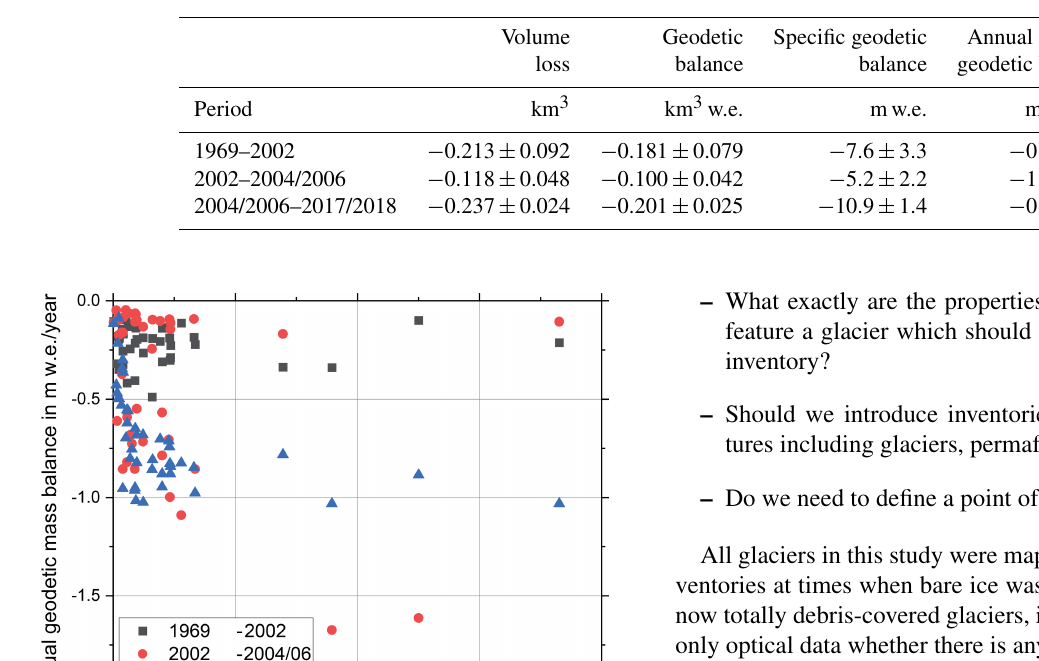
Table 4. Glacier volume loss, geodetic balance (total, specific, and specific annual) in the Austrian part of the Silvretta between 1969, 2002, 2004/2006, and 2017/2018. For Vorarlberg, lidar flights were carried out in 2004 and 2017 and for Tyrol in 2006 and 2018.